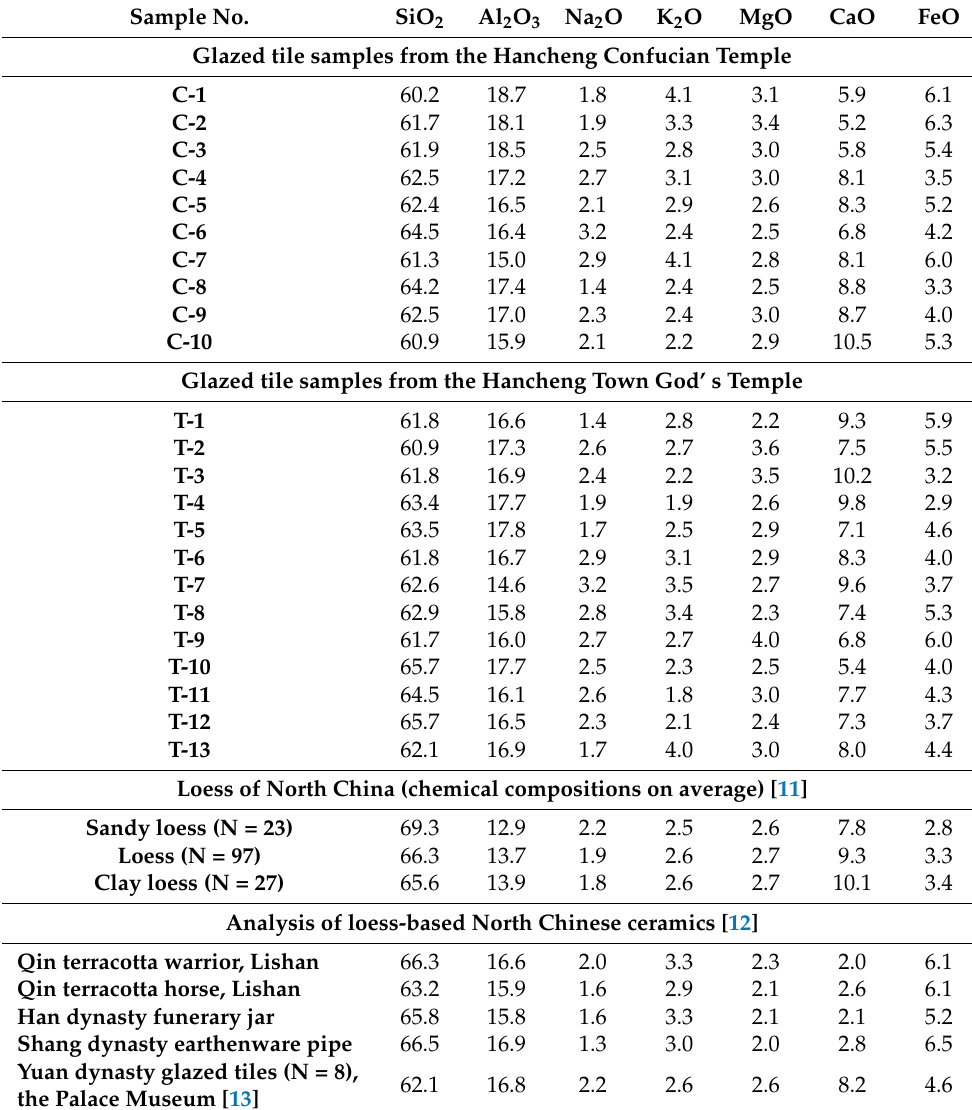
Table 2. Major chemical compositions of the body of Hancheng glazed tile samples and loess from North China (wt.%). The data of loess from North China is taken from Wu et al. (1996) [11]; loess- based north Chinese ceramics is from Wood (2011, 197) [12]; glazed tiles of the Palace Museum is from Kang et al. (2018) [13] and the N means number of samples. Sample